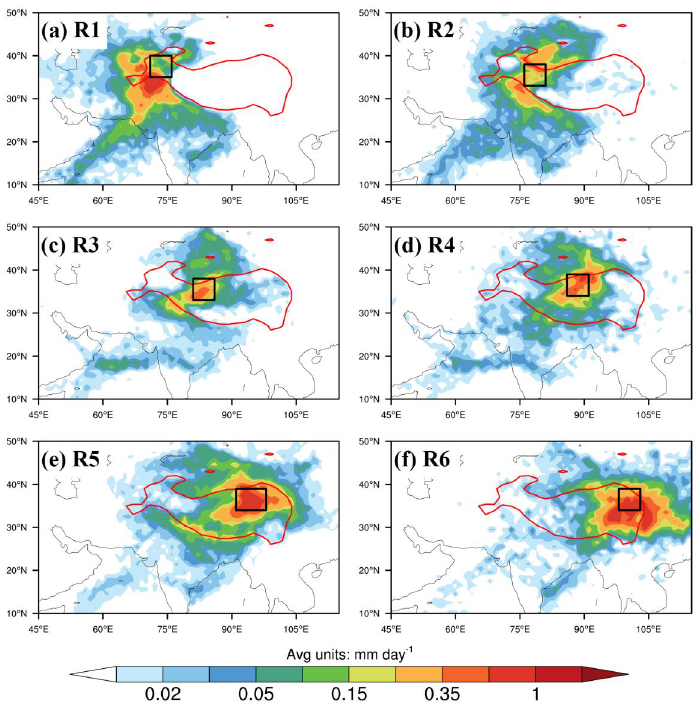
Figure 3. Spatial distributions of mean contributions (units: mm day − 1 ) of moisture sources for ten extreme precipitation events over the six subregions. The solid red line denotes the boundary of Tibetan Plateau with an elevation higher than 2500 m. Black rectangles in the panels ( a – f ) represent the subregions, respectively.